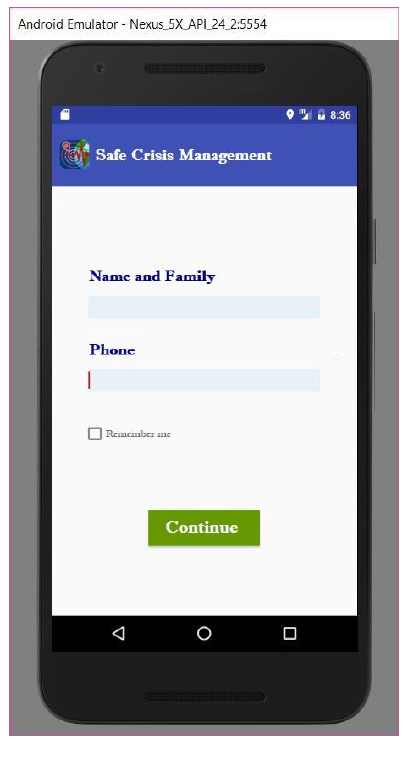
Figure 13. Range of Mikrotik DynaDish 5 in